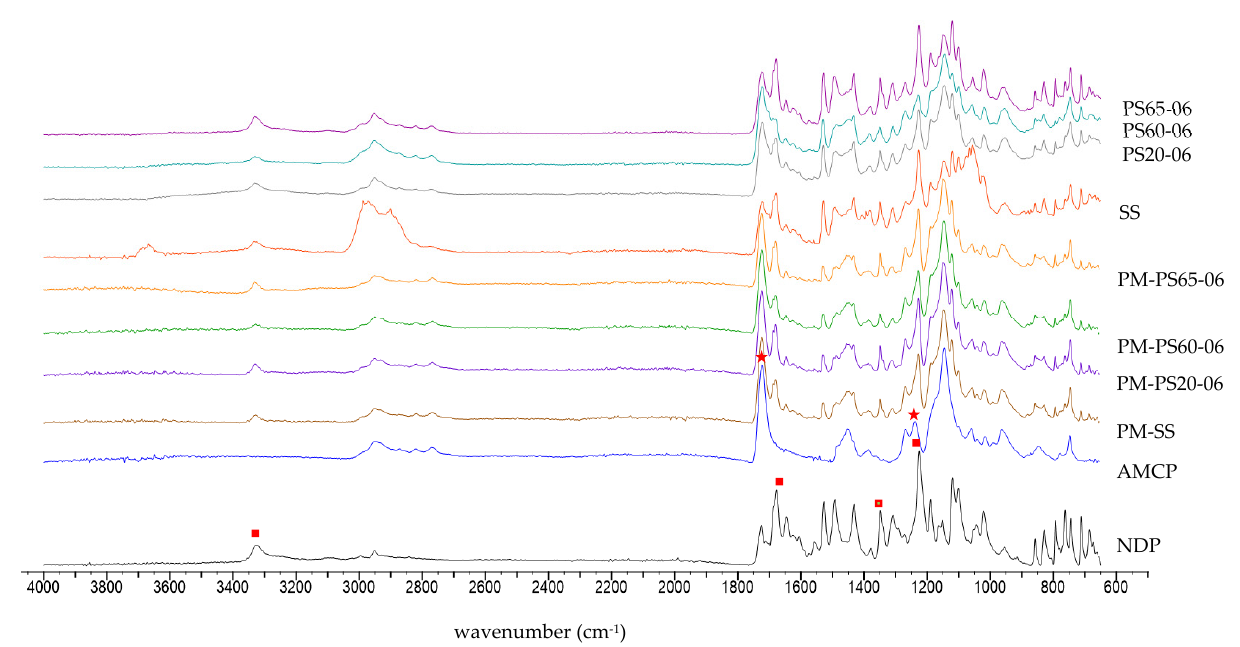
Figure 4. FTIR spectrum of NDP, AMCP, physical mixtures (PMs), SS, PS20-06, PS60-06 and PS65-06: red square represent major functional groups in NDP while red star represent main functional groups in AMCP. Table 2. Surface free energy and its components obtained by sessile drop measurement. Surface Free Formulation